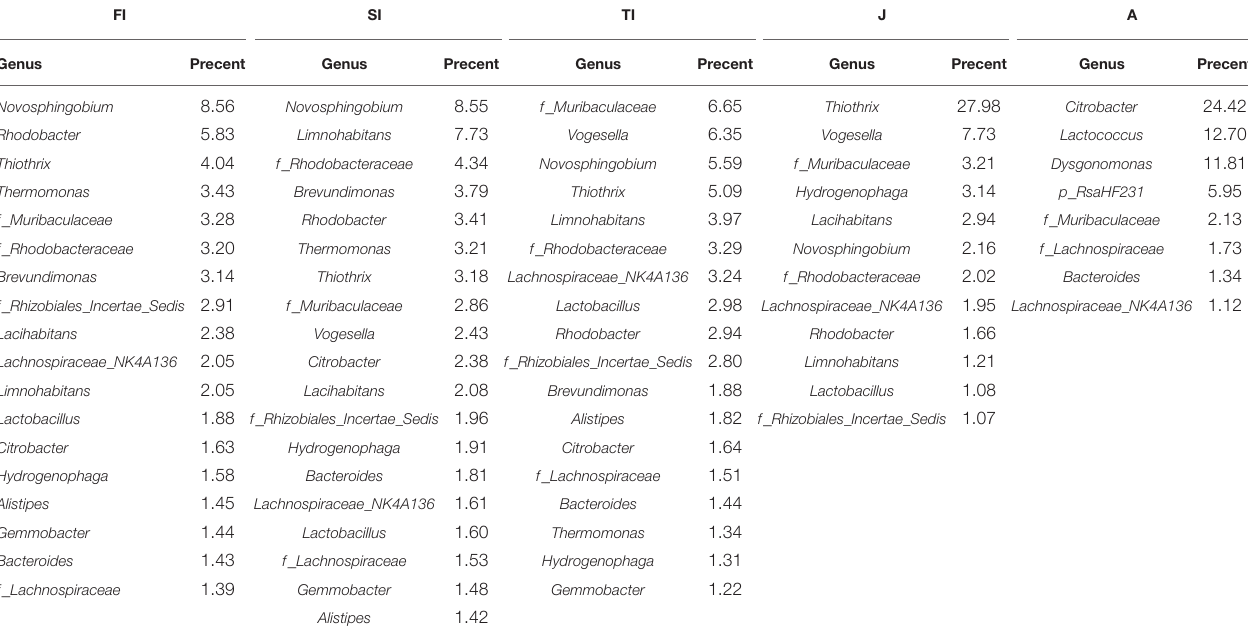
TABLE 1B | The relative abundance of gut abundant microbiota among the samples at the phylum level (a) and genus level (b).